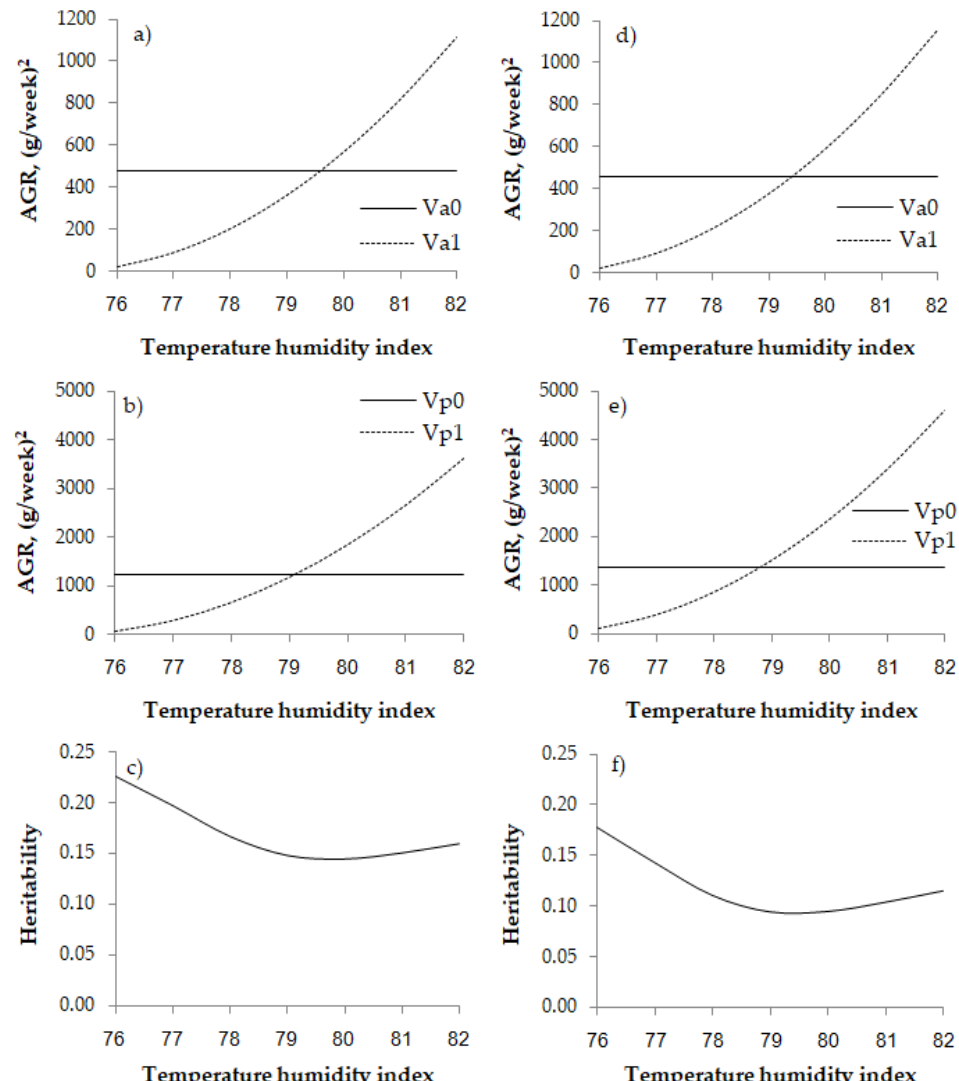
Figure 5. Estimates of additive genetic variance without consideration of heat tolerance (intercept, Va0, solid line), additive genetic variance for heat tolerance (slope, Va1, dashed line) ( a , d ), permanent environmental variance without consideration of heat stress (intercept, Vp0, solid line), permanent environmental variance of heat tolerance (slope, Vp1, dashed line) ( b , e ), and heritability ( c , f ) using the Gompertz function in purebred Thai native chickens (all left figures) and Thai synthetic chickens (all right figures).